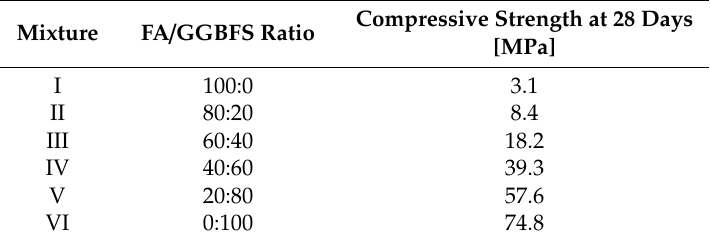
Table 3. Geopolymer mortar compressive strength, without heat treatment, depending on the fly ash / ground granulated blast furnace slag ratio